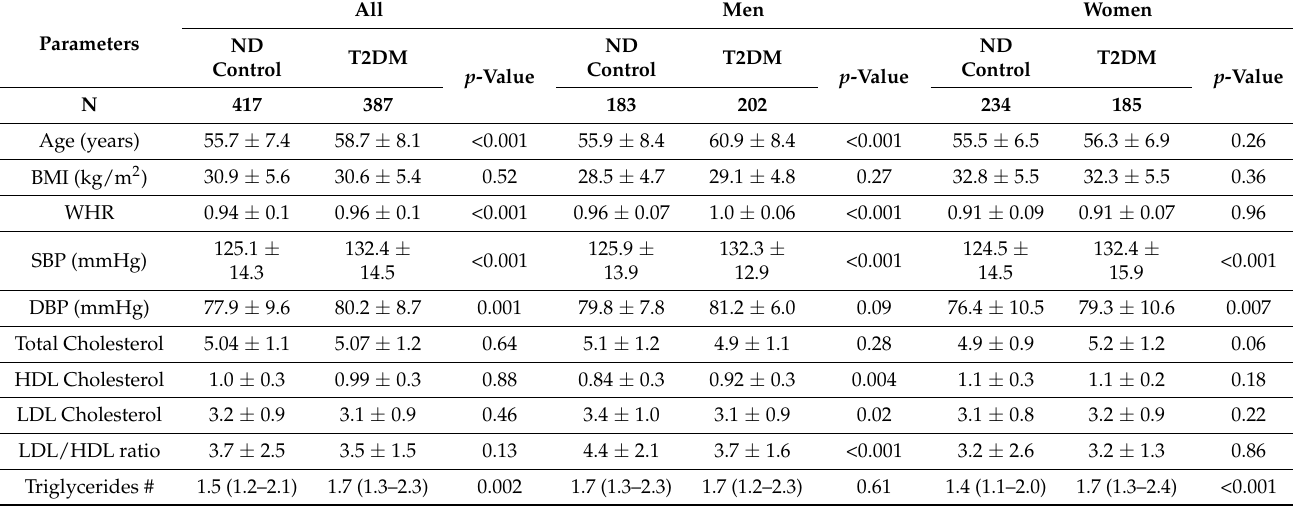
Table 2. Anthropometrics and lipid profile of